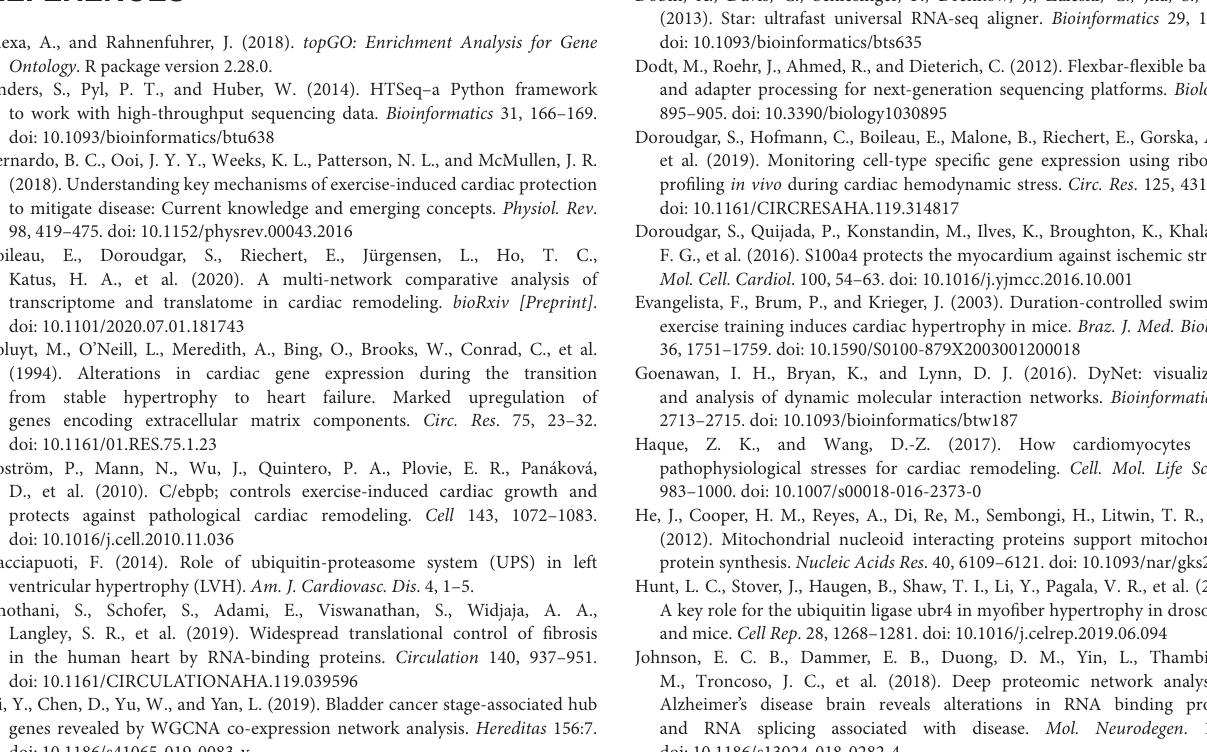
Supplementary Figure 5 | Translatome (Ribo) network modules were clustered to assess relatedness based on correlation of co-expressed eigengenes. Supplementary Figure 6 | Hub genes provide a different molecular signature for differentiating physiological and pathological cardiac remodeling. Supplementary Figure 7 | Hub genes provide a different molecular signature for differentiating physiological and pathological cardiac remodeling. Supplementary Figure 8 | Differential connectivity and differential translational-efficiency. Supplementary Figure 9 | Rewired genes are associated with different biological processes, molecular functions and cellular components in transcriptome vs. translatome. Supplementary Table 1 | Open reading frame predictions per sample, all categories, Rp-Bp output. Supplementary Table 2 | Open reading frame predictions, unique (translated genes used in this study). Supplementary Table 3 | Transcriptome and translatome read counts used as input for network analyses. Supplementary Table 4 | Transcriptome and translatome co-expression modules. Supplementary Table 5 | Gene ontology enrichment of transcriptome and translatome co-expression modules. Supplementary Table 6 | Transcriptome and translatome co-expression modules correlation association and significance. Supplementary Table 7 | Extended differential translational-efficiency (DTE) results. Supplementary Information | Code for generating co-expression